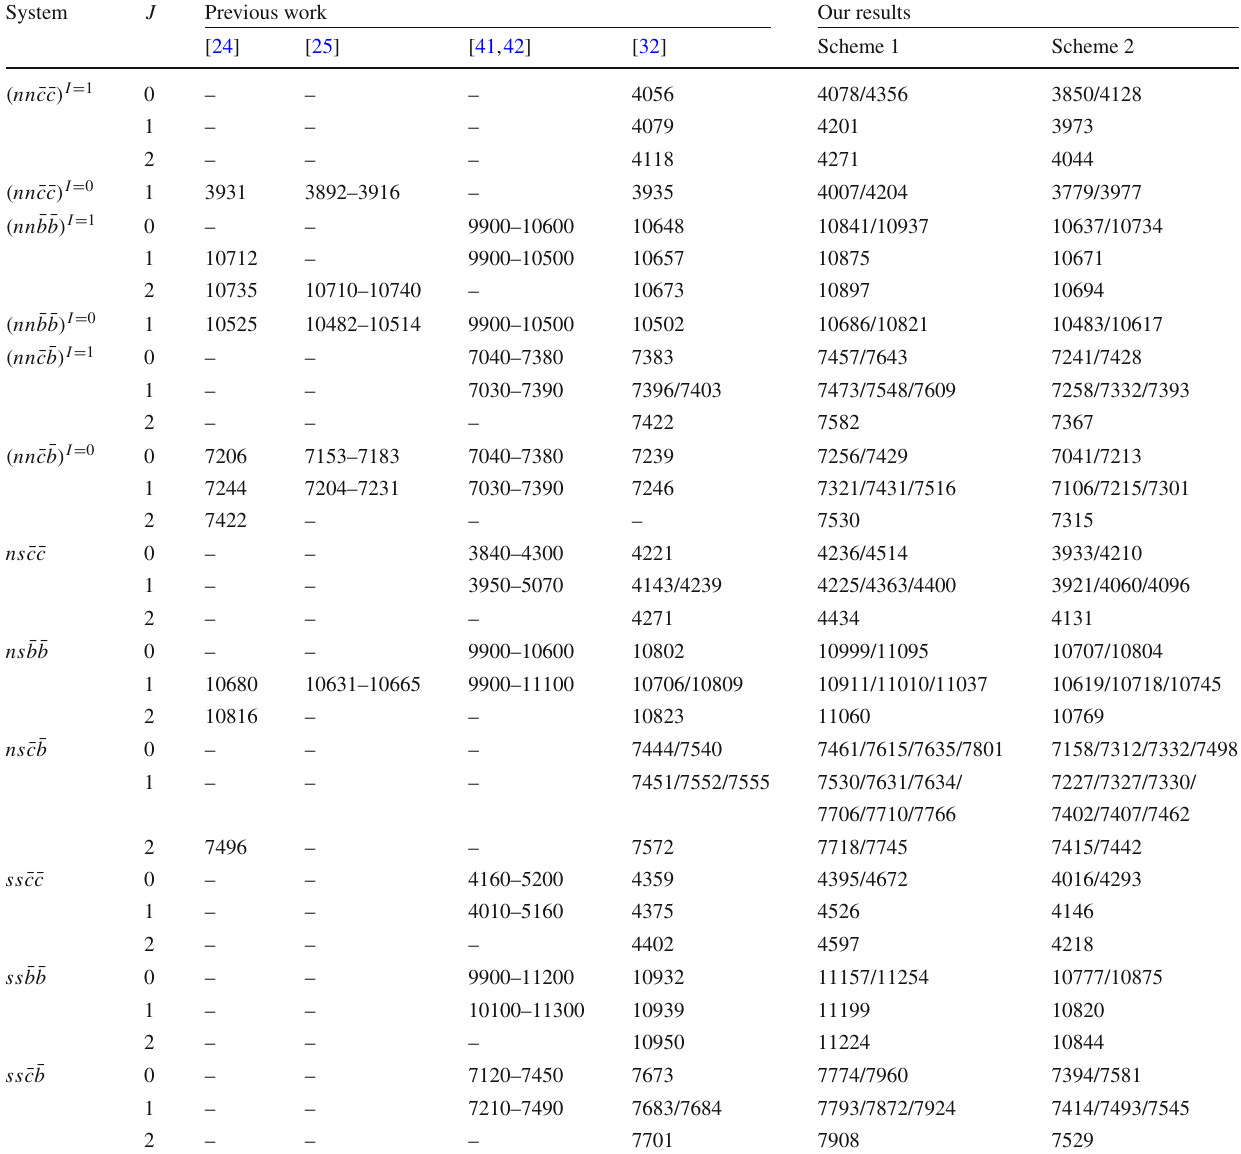
Table 9 Comparison of results in various methods for tetraquark states with the qq ¯ Q ¯ Q